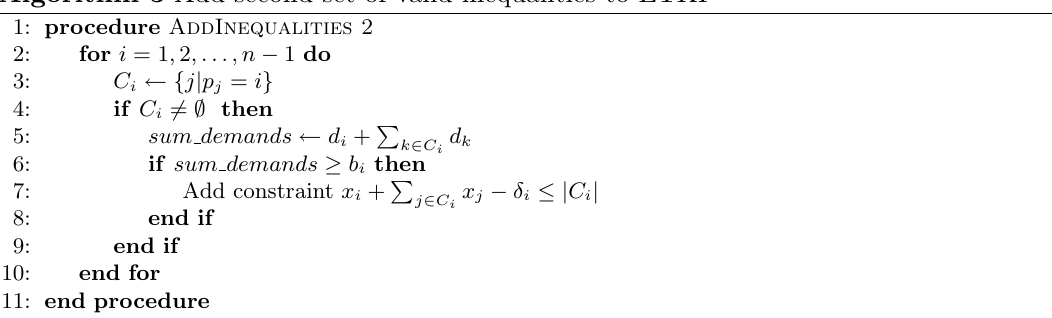
Algorithm 3 Add second set of valid inequalities to ETKP